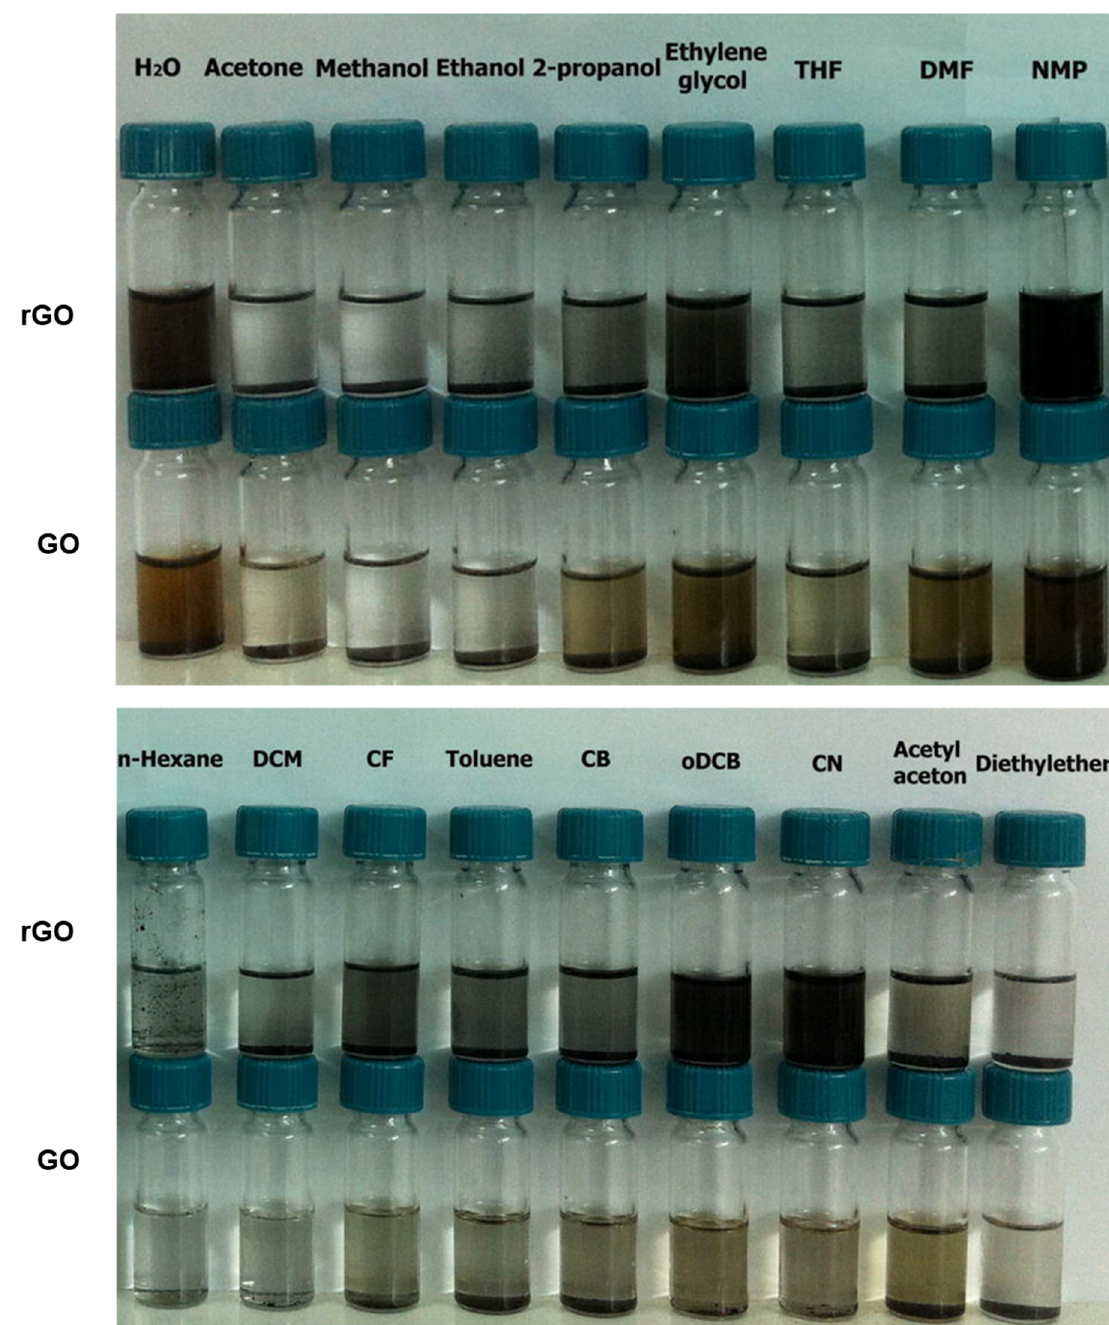
Figure 3. Photographic images of GO and rGO dispersions in different solvents. Reproduced with permission from [74] .